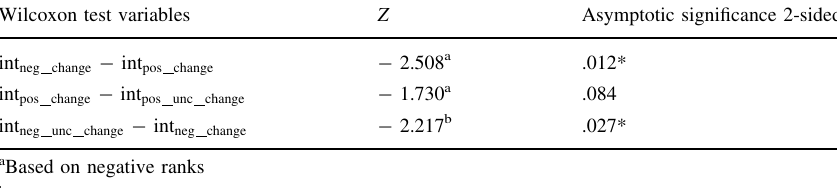
Table 8 Intention changes differences using a Wilcoxon